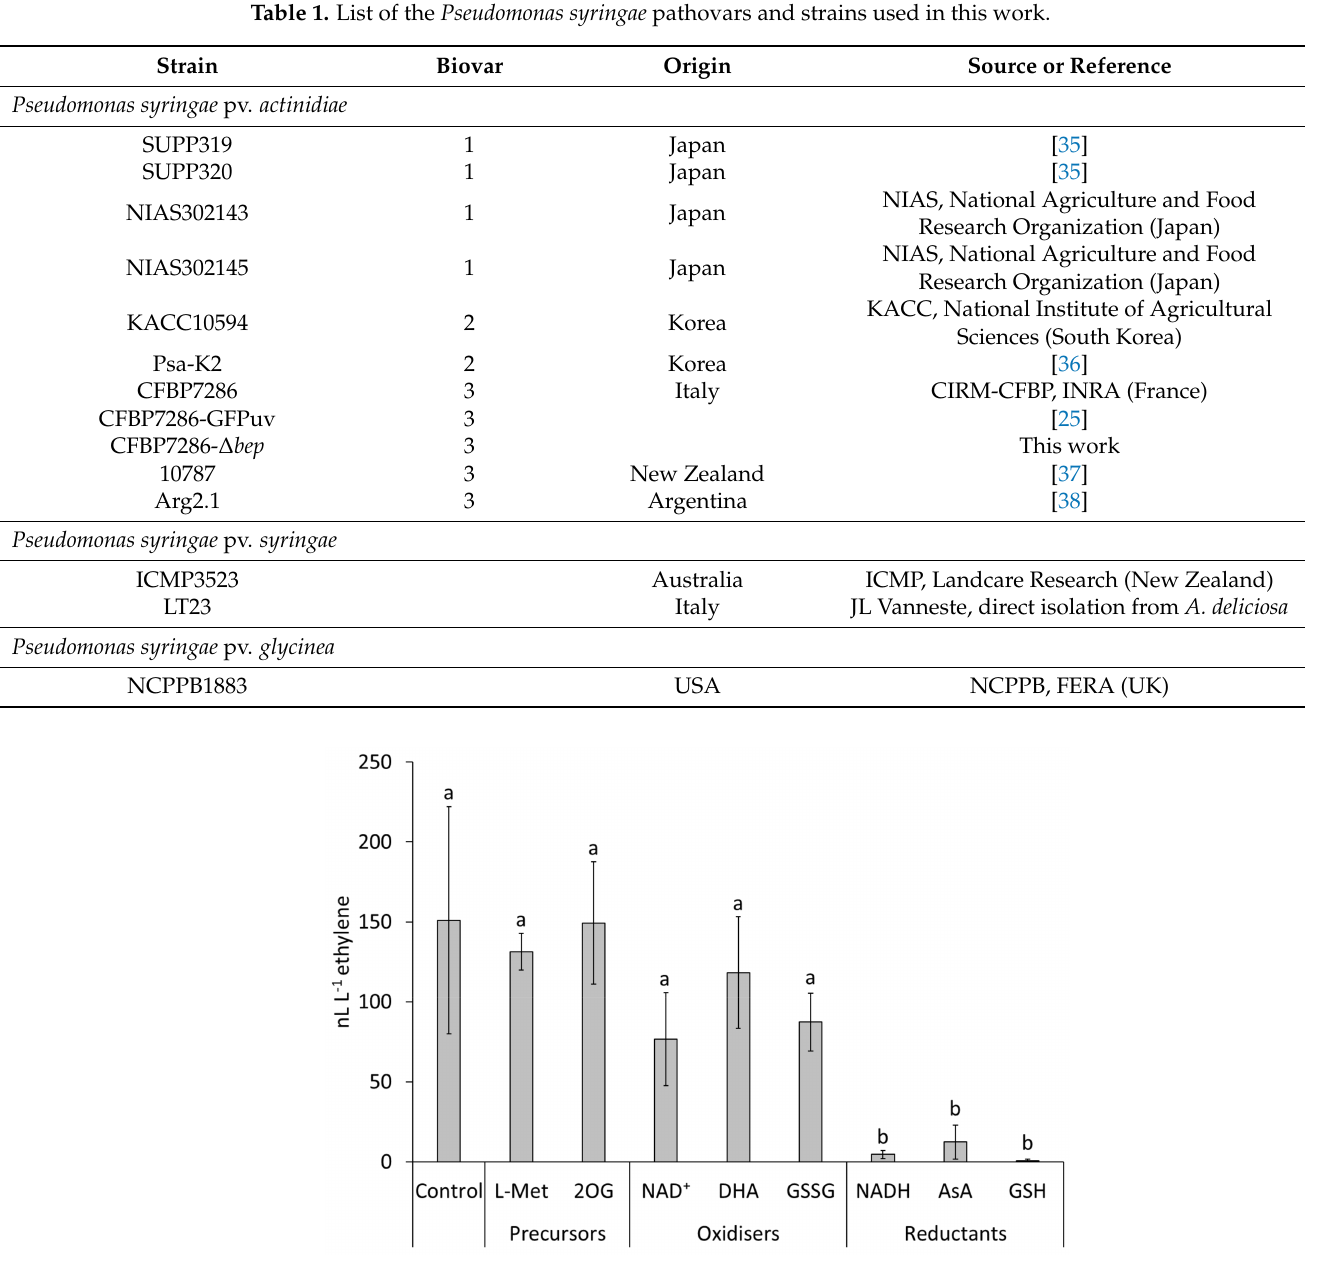
Figure 3. Ethylene emissions of Pseudomonas syringae pv. actinidiae strain CFBP7286. Measures were taken 72 h after inoculation in modified liquid media containing 1 mM L-methionine (L-Met), 10 mM 2-oxoglutarate (2OG), 2 mM NAD + , 2 mM dehydroascorbate (DHA), 1 mM oxidised glutathione (GSSG), 2 mM NADH, 2 mM ascorbic acid (AsA), or 2 mM glutathione (GSH). Different letters indicate significantly different ( p ≤ 0.05, n = 3) ethylene emissions, according to ANOVA and Fisher’s least significant difference